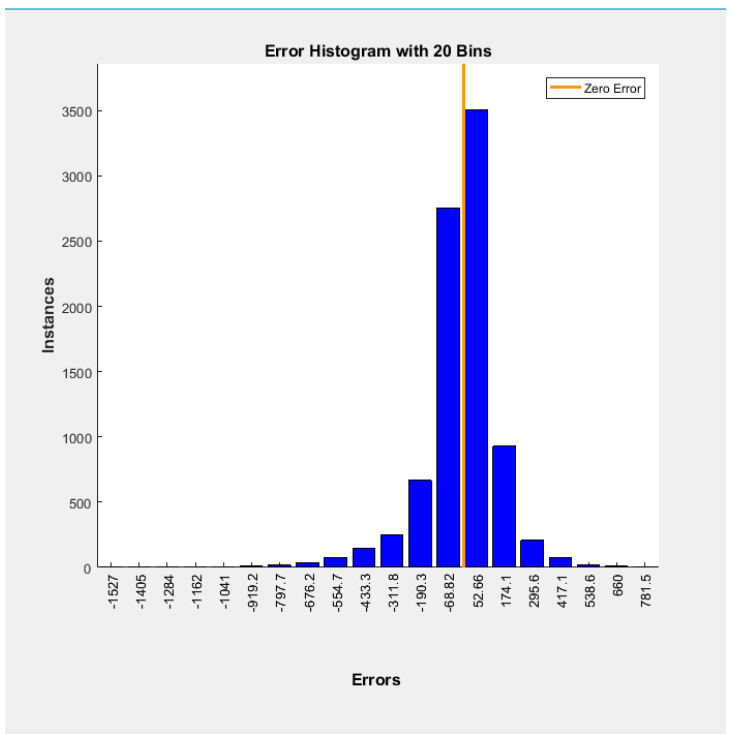
Figure 9. Error histogram for the fit set.